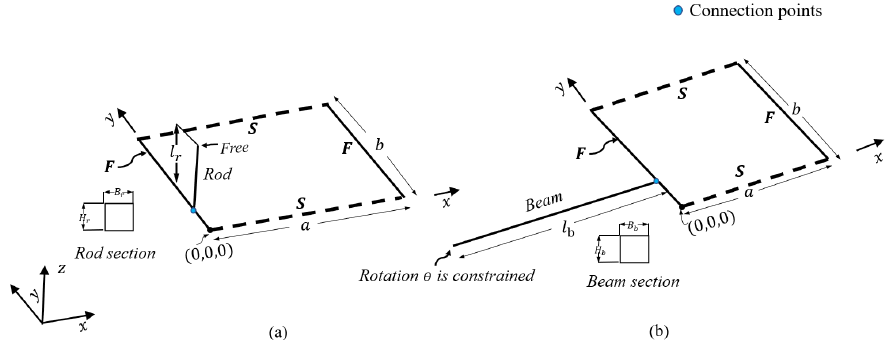
Figure 15. A plate connected to ( a ) a rod or ( b ) a beam at position (0,0.25,0). For the problem shown in Figure 15a: plate thickness h pl = 0.003 m and density of plate material ρ pl = 3000 kg/m 3 ; rod Young’s modulus E r = 2 × 10 8 Pa, rod density ρ r = 2700 kg/m 3 , rod cross section B r = H r = 0.003 m and length l r = 0.3 m. In Figure 15b: plate thickness h pl = 0.006 m, density of material ρ pl = 2700 kg/m 3 ; beam Young’s modulus E b = 2 × 10 10 Pa, density ρ b = 2700 kg/m 3 , cross section B b = H b = 0.004 m and length l b = 1.4 m.